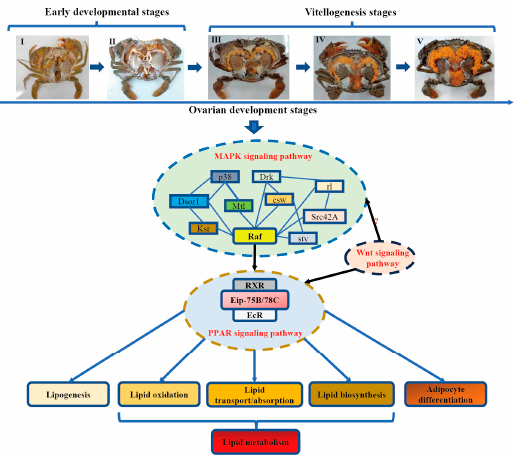
Figure 9. Schematic diagram of hypothetical mechanism of several key signaling pathways regulating lipid metabolism in S. paramamosain .